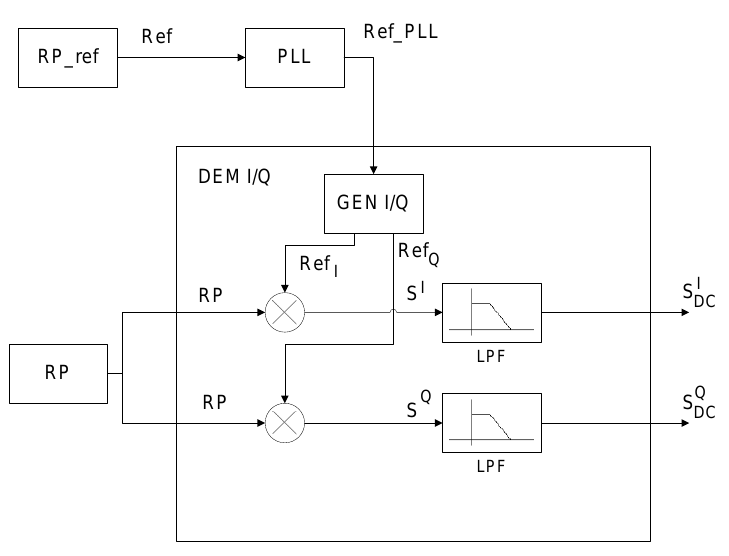
Figure 11. Signal treatment